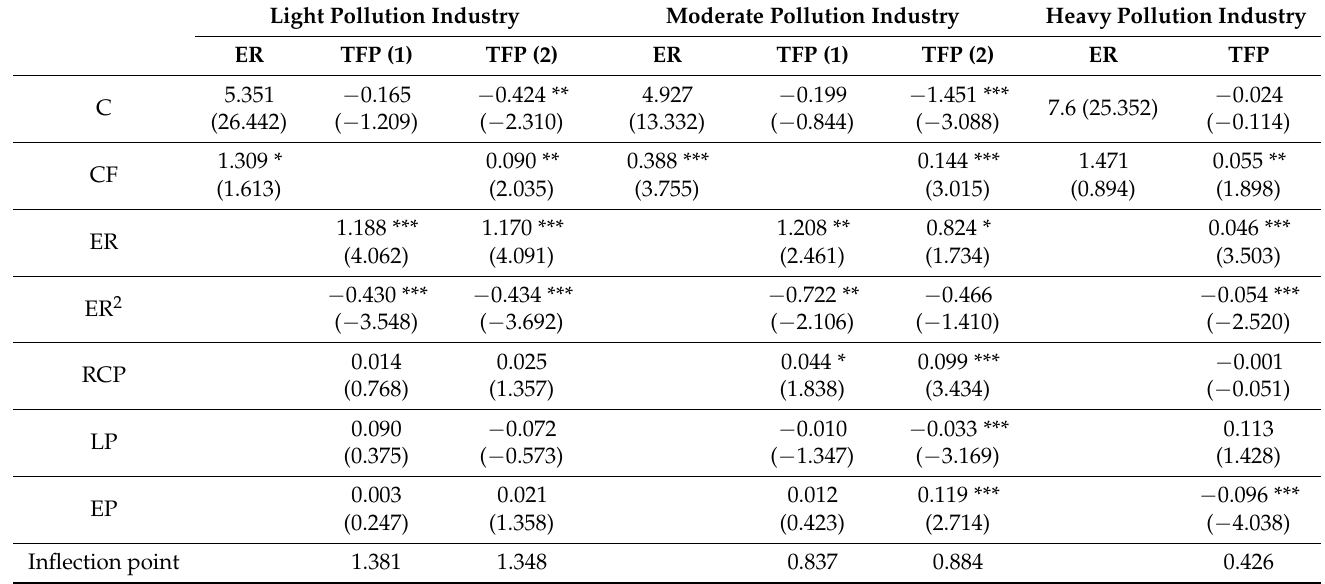
Table 7. Regression results by